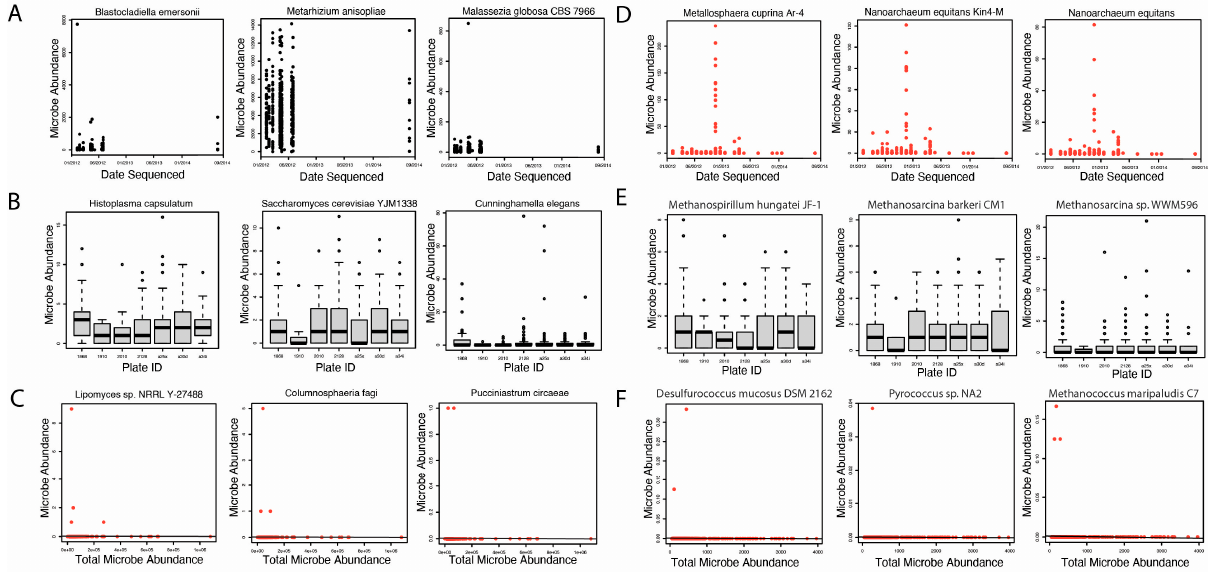
Figure 2. Selected plots from contamination correction analysis. Plots with red datapoints represent microbes that were identified as potential contaminants. A full list of contaminants for each contamination correction method is available in Supplementary File S1. ( A ) Selected scatter plots for fungal species assessed for contamination correction by sequencing date. The date of sampling sequencing is represented on the x-axis, and microbe abundance is represented on the y-axis. Potential contaminants were defined as microbial plots with an abundance cluster around one specific date. No potential fungal contaminants were identified using this contamination correction method. ( B ) Selected boxplots for fungal species assessed for contamination correction by sequencing plate. Sequencing plates are represented on the x-axis, and microbe abundance is represented on the y-axis. Potential contaminants were defined as microbial plots in which the abundance for a particular sequencing plate was unusually high compared to others. No potential fungal contaminants were identified using this contamination correction method. ( C ) Selected scatter plots for fungal species assessed for contamination correction by total microbial abundance. Total microbial fungal microbe abundance is represented on the x-axis, while microbial abundance for a specific microbe is represented on the y-axis, for each patient. Potential contaminants were defined as microbial plots in which the linear regression analysis exhibited a slope of zero (margin of error ± 0.1). A total of 1492 fungal species were identified as potential contaminants when compared to total microbial abundance. Selected plots of three potential contaminant species are shown here. ( D ) Selected scatter plots for archaeal species assessed for contamination correction by sequencing date. A total of 6 archaeal species were identified as potential contaminants according to sequencing date. ( E ) Selected boxplots for archaeal species assessed for contamination correction by sequencing plate. No potential archaeal contaminants were identified using this contamination correction method. ( F ) Selected scatter plots for archaeal species assessed for contamination correction by total microbial abundance. A total of 286 archaeal species were identified as potential contaminants when compared to total microbial abundance. Selected plots of three potential contaminant species are shown